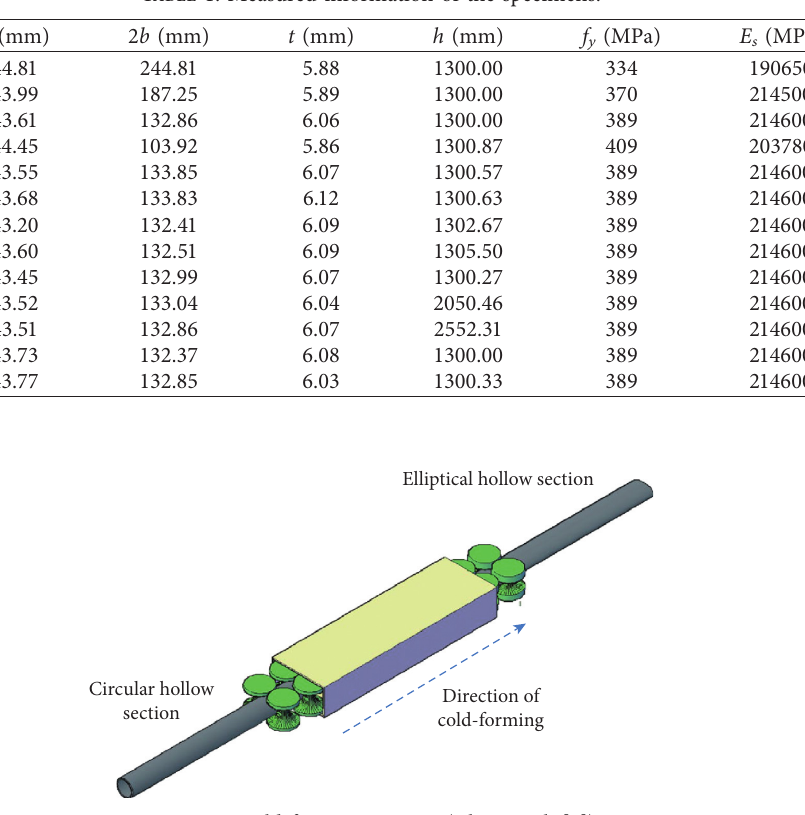
Figure 3: Cold-forming process (Chan et al .